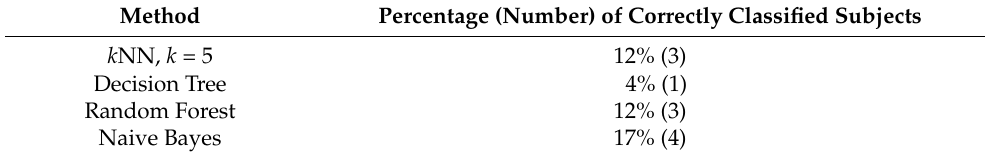
Table 5. The accuracy obtained on the class level for the four classification methods– the train and test sets built from the different sessions.